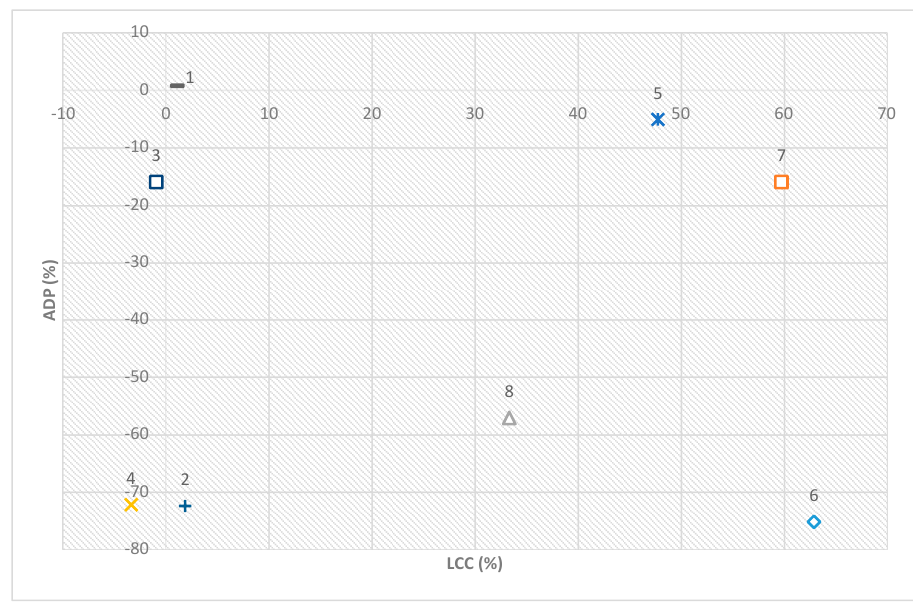
Figure 6. Abiotic depletion potential of nonfossil elements against life cycle costs.